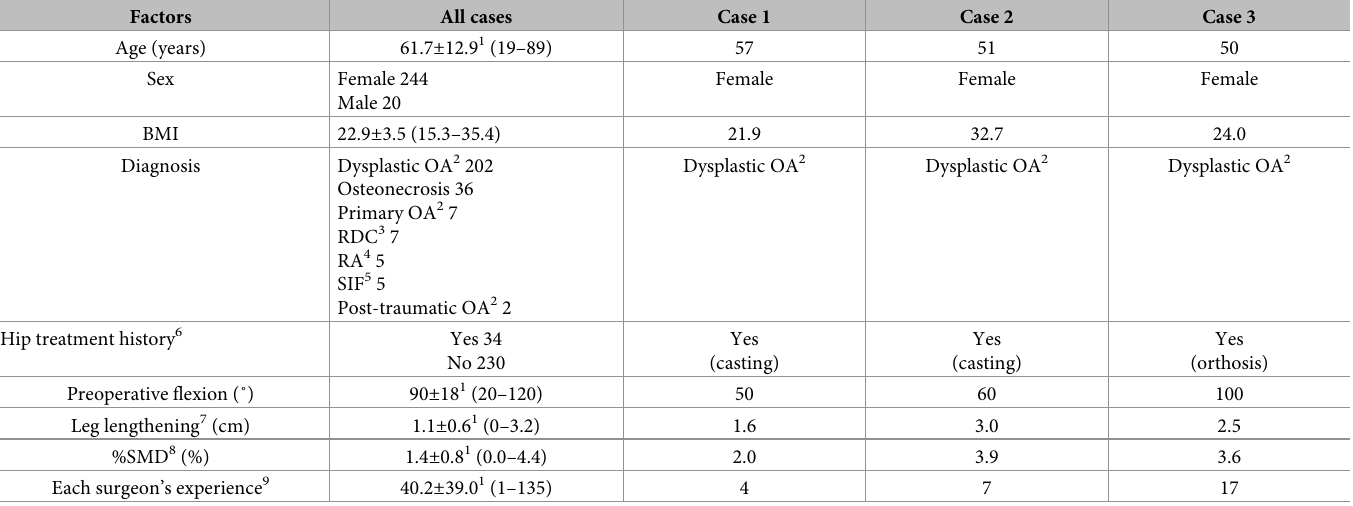
Table 1. Characteristics of the study